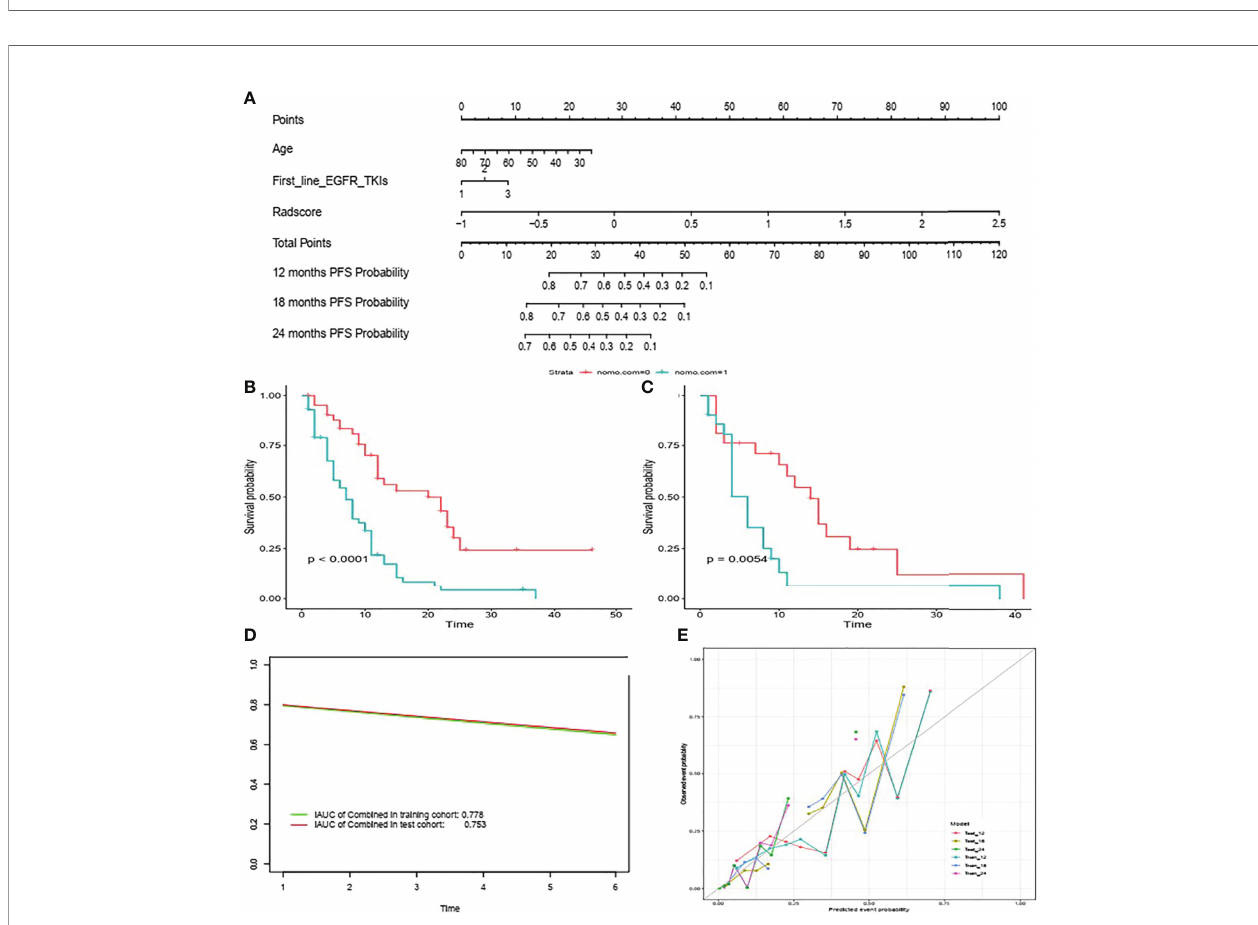
FIGURE 4 | Nomogram for predicting PFS in patients with acquired T790M mutation treated with osimertinib (A) Risk strati fi cation in the training set (B) and validation set (C) . Time-dependent ROCs were plotted in the training as well as validation sets at 6 months (D) Calibration curves of the nomogram to validate the 12m, 18m and 24m PFS rate in the training set and validation set (E) .